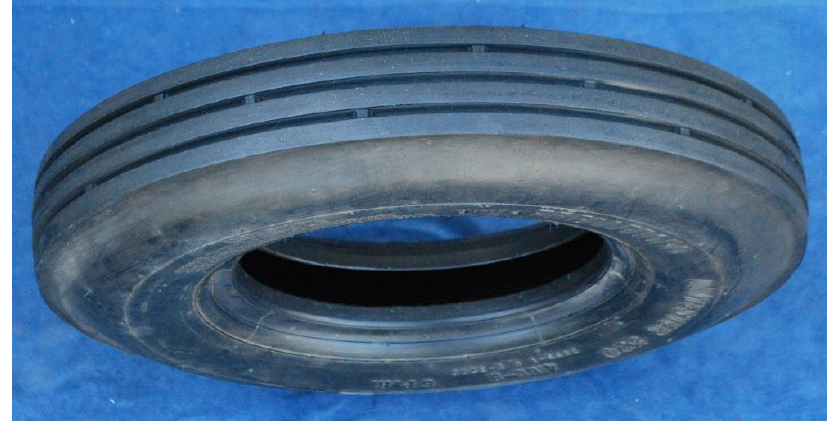
Figure 4. ASFT (airport surface friction tester) T520 tire.